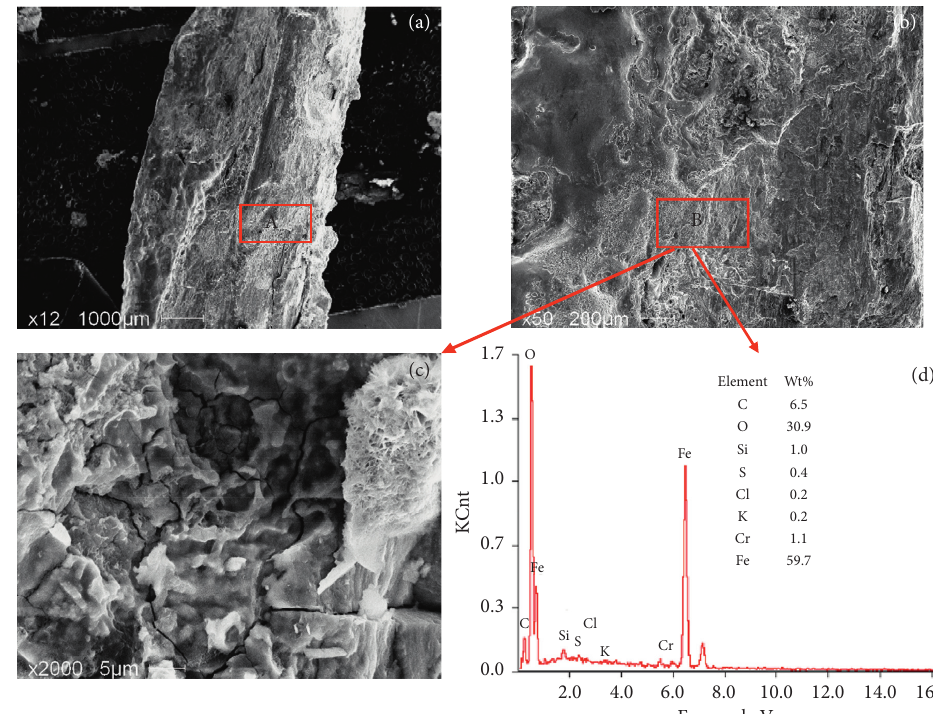
Figure 8: Morphology and EDS analysis of fracture surface corrosion products: (a) with 12 times magnification; (b) point A with 50 times magnification; (c) point B with 2000 times magnification; (d) EDS